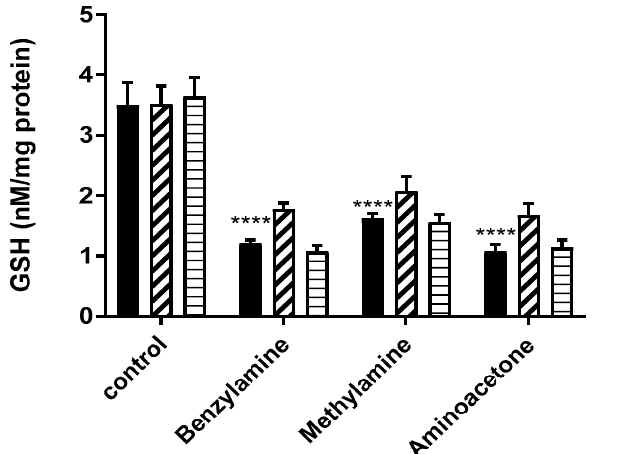
Figure 6. Fluorescent images depicting ROS production in: cells treated with 1× PBS (( A ), negative control), 5 µM DMNQ (( B ), positive control), 500 µM benzylamine ( C ), 500 µM benzylamine + 100 µM MDL72527 ( D ), 500 µM methylamine ( E ), 500 µM methylamine + 100 µM MDL72527 ( F ), 45 µM